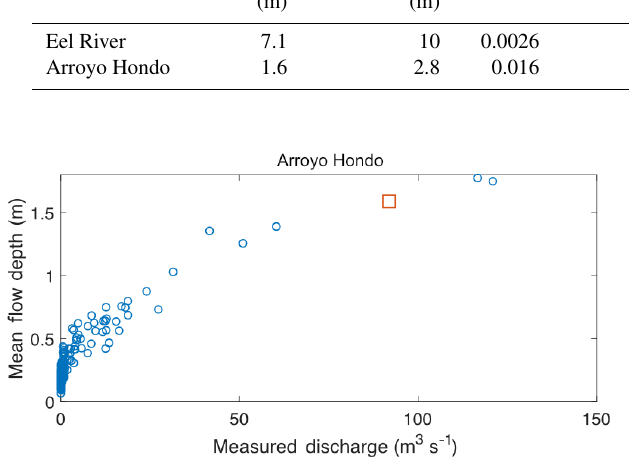
Figure 9. Mean flow depth versus measured discharge for the USGS Arroyo Hondo gage. Red square indicates the interpolated 2-year recurrence interval depth.